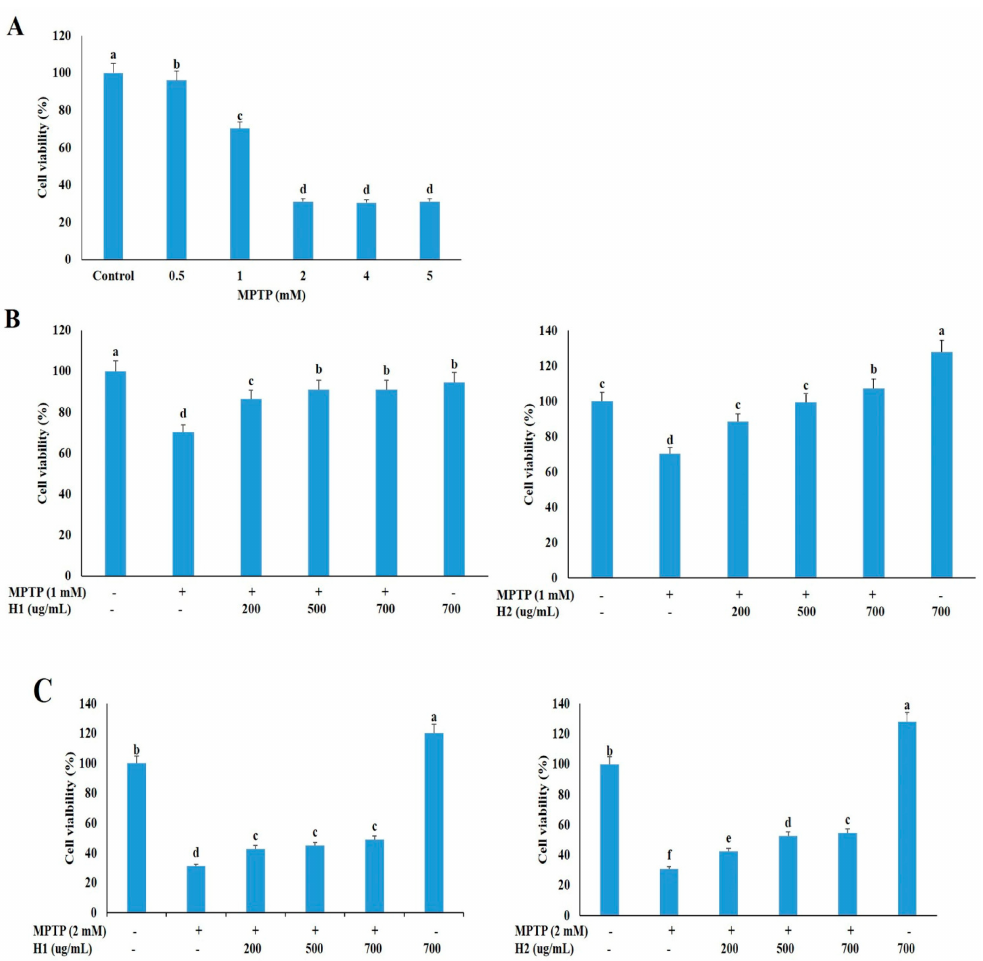
Figure 1. Hepad 1 (H1) and Hepad 2 (H2) inhibit 1-methyl-4-phenyl-1,2,3,6-tetrahydropyridine (MPTP)-induced cell death in SH-SY5Y cells. ( A ) SH-SY5Y cells (2 × 10 6 ) were incubated in the